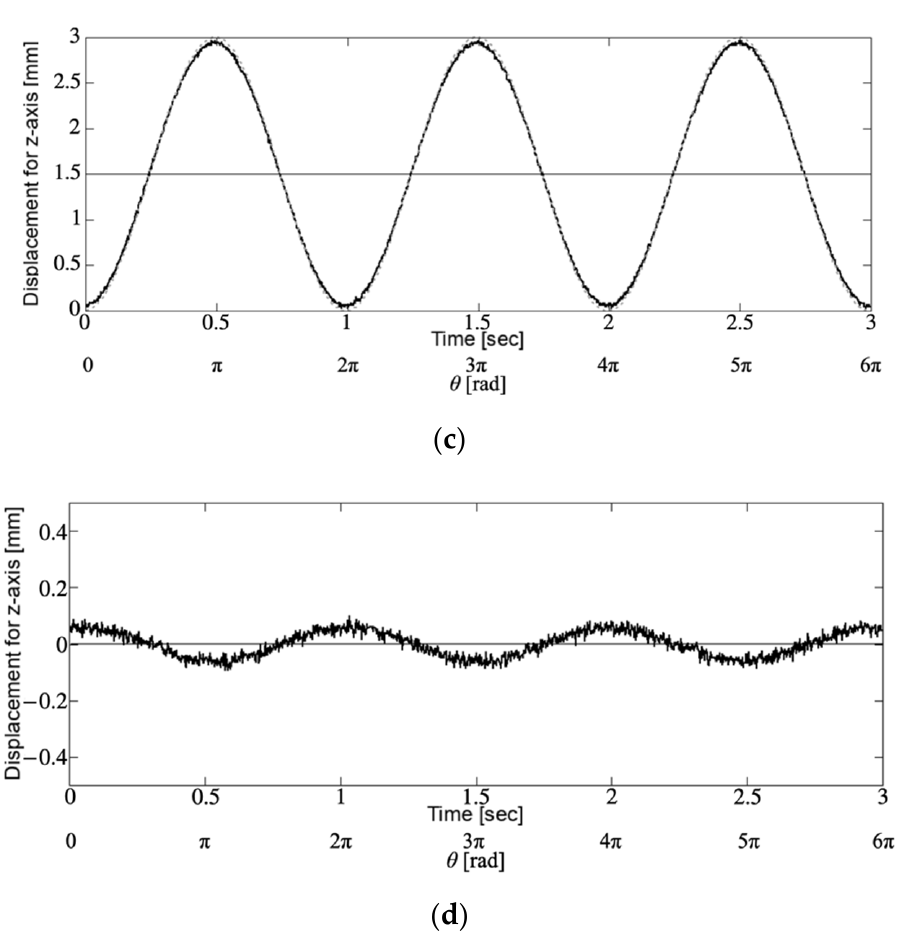
Figure 6. Imaging sensor displacement for ( a ) x-axis, ( b ) y-axis, and ( c ) z-axis directions. For ( a ) and ( b ), the time duration was 0.5 s. For ( c ), it was 3 s. In ( c ), the dashed curve shows the ideal points, and the curve shows the measurements by the laser displacement meter. The error of data shown in ( c ) relative to the sine wave is highlighted by ( d ). The vertical axes are in the 1 mm range for ( a ), ( b ), and ( d ), and 3 mm range for ( c ).